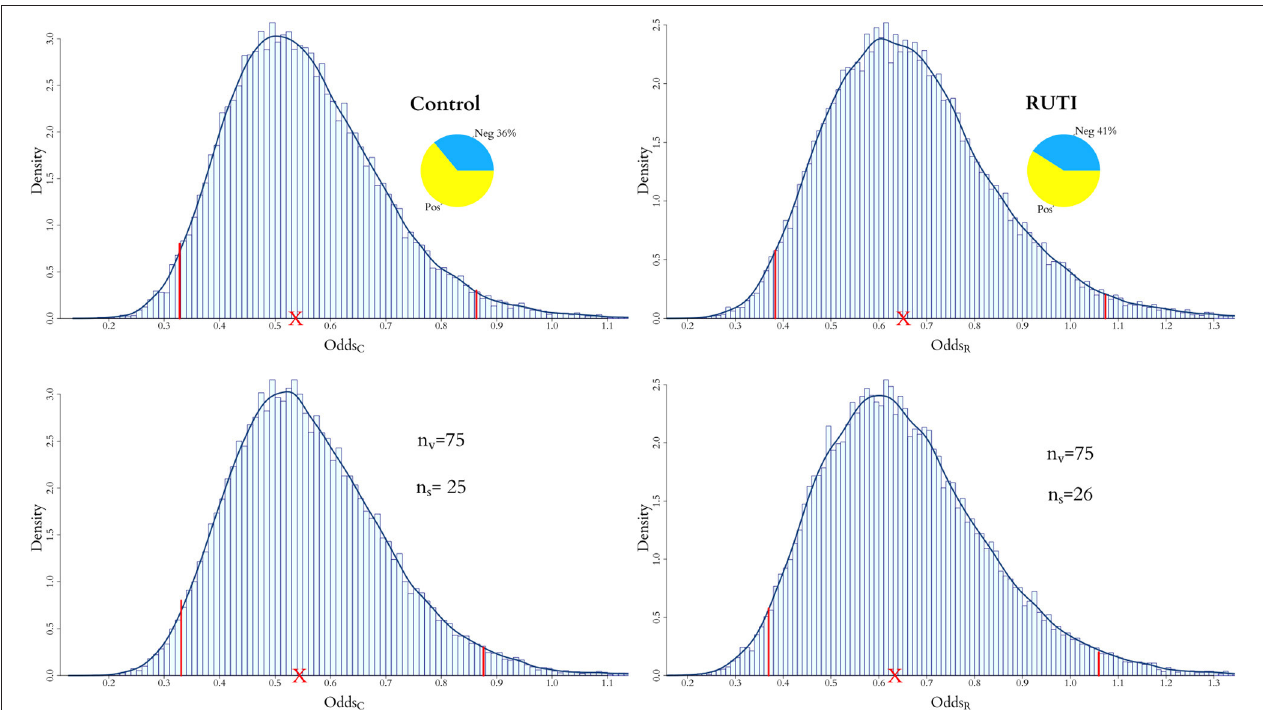
FIGURE 7 | Posterior distribution of odds for both RUTI and Control groups, when only the in vivo cohort is fitted and when both the in vivo and in silico cohorts are combined for the full model. For the latter, the optimal number of virtual patients n s for each group is selected according to the weights in Figures 5 , 6 .